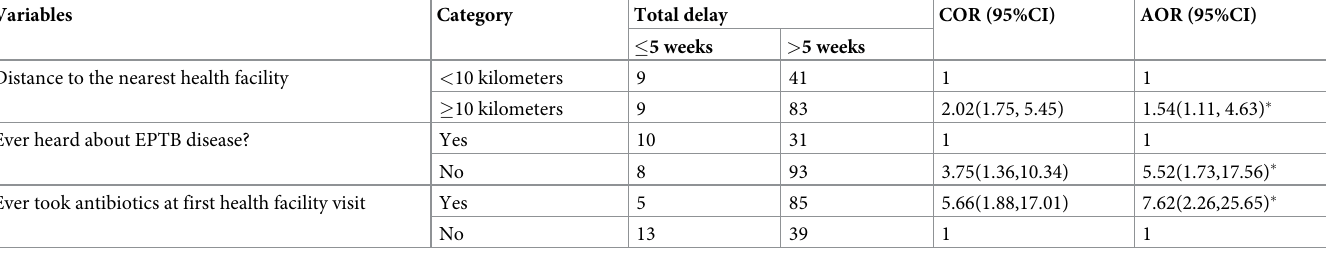
Table 5. Analysis of factors associated with diagnostic delay of EPTB patients at public health facilities of North Shewa zone, Ethiopia, April 2021. Variables